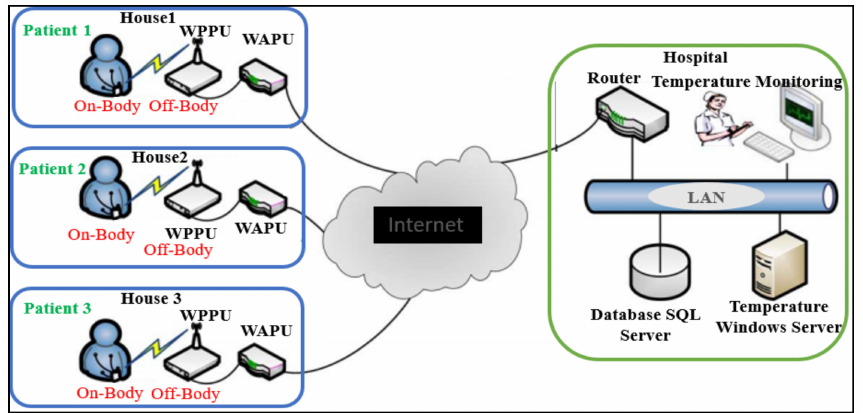
Figure 1. A general healthcare architecture for integrated meander line antenna. WPPU: wireless patient portable unit; WAPU: wireless-access point unit; LAN: local area network; QoS: quality of service